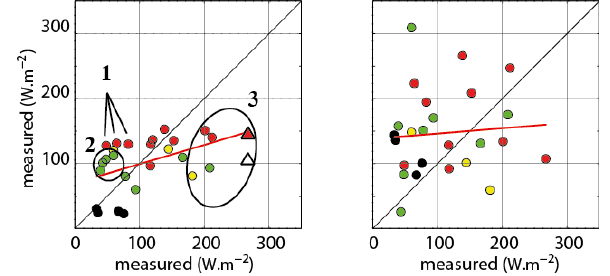
Fig. 6. Computed versus measured soil heat flux for SEB mod- els (left panel) and ICARE (right panel). The only point dif- fering between TSEB and the other SEB methods has been re- ported as a white-faced triangle, the Bastiaanssen (2000) esti- mation being reported as a red-faced triangle. Color code: red: LAI < 0.4; yellow: 0.4 ≤ LAI < 0.8; green: 0.8 ≤ LAI < 1.2; navy- blue: 1.2 ≤ LAI < 2.0; black: LAI ≥ 2.0.